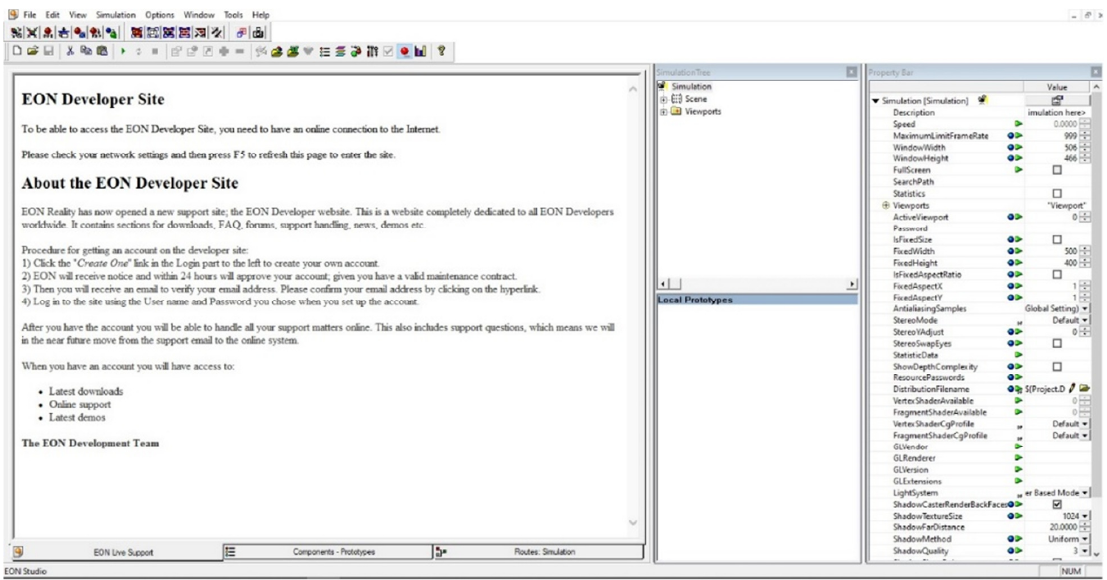
Fig. 2. Default EON Studio